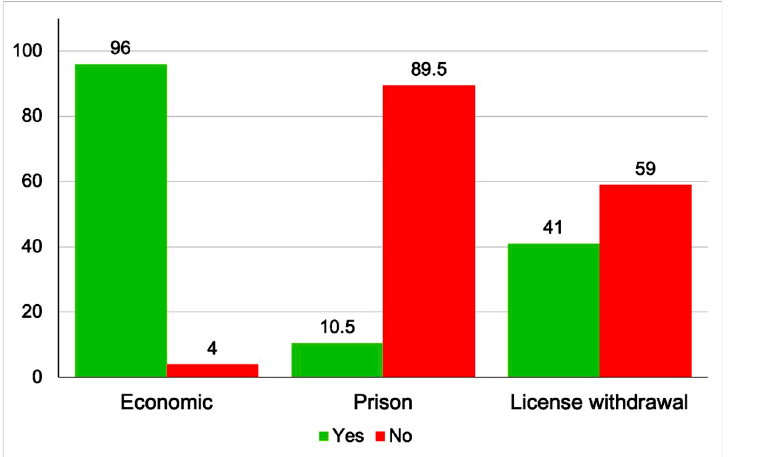
Fig 3. Type of sanction considered in case of VTI certificate infraction.